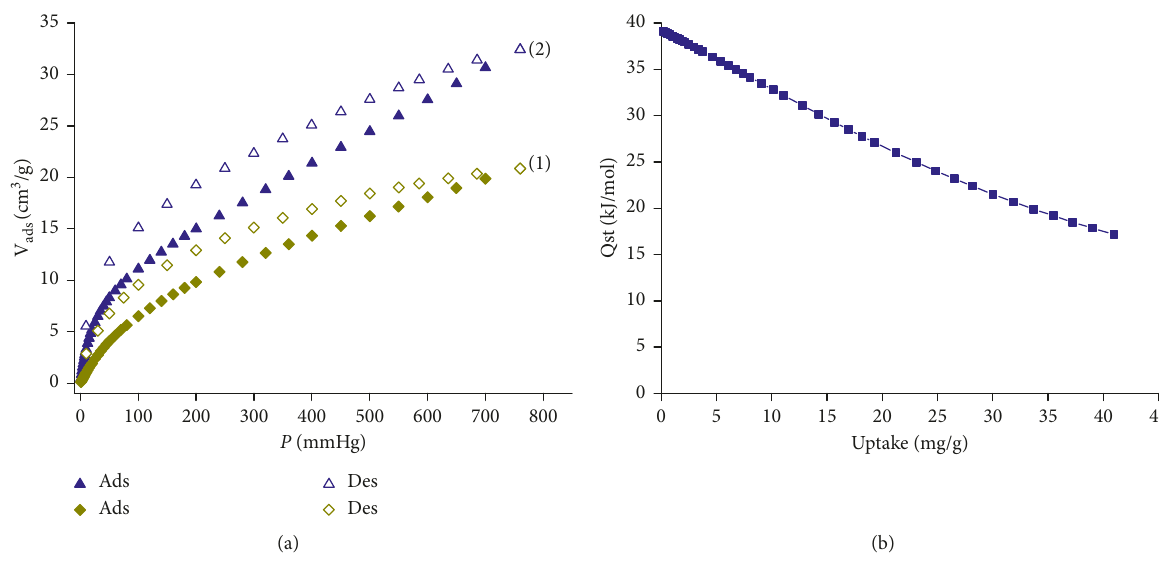
Figure 5: (a) CO 2 adsorption isotherms for compound 1 at 298K (1) and 273 K (2)